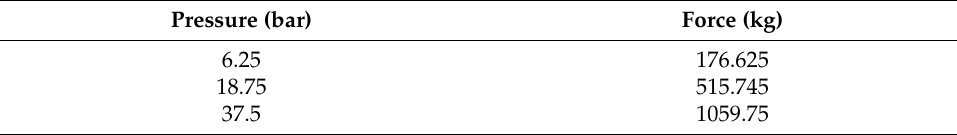
Table 2. The force values that occurred according to variable pressure values.